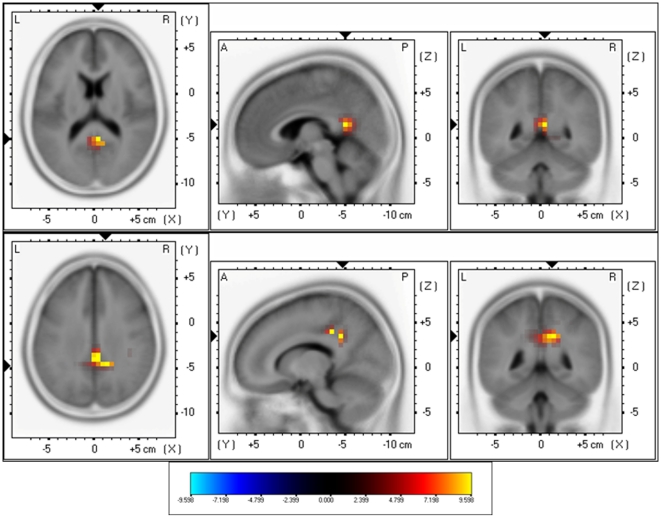
sLORETA contrast analysis between Pure Tone tinnitus patients versus Control subjects (p<.05).Increased activity within Beta (25–30 Hz; Top Panel) and Gamma (30.5–45 Hz; Bottom Panel) in the posterior cingulate cortex (PCC; BA31) for patients with bilateral pure tone tinnitus in comparison to controls.